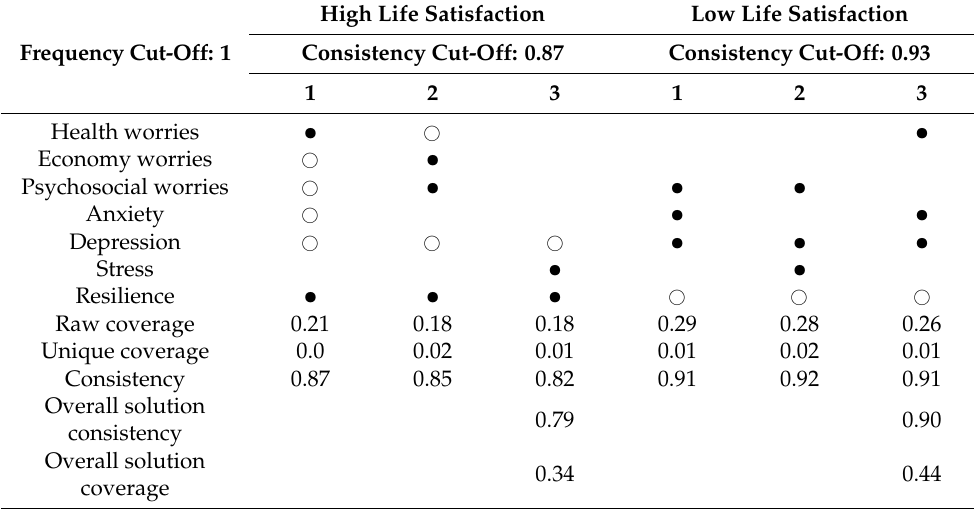
Table 4. Summary of the main sufficient conditions for the intermediate solution of life